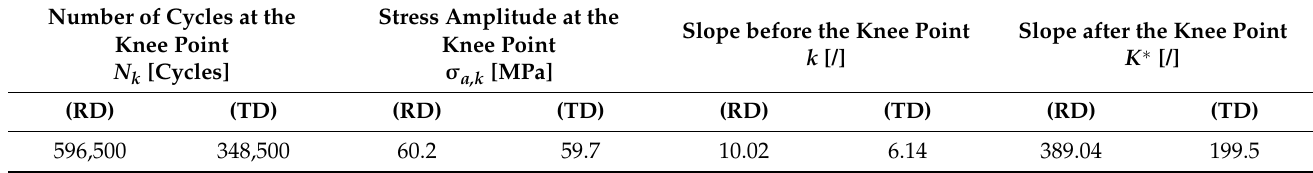
Table 3. Fatigue parameters of AA 5083-H111 related to the bilinear S–N curve.